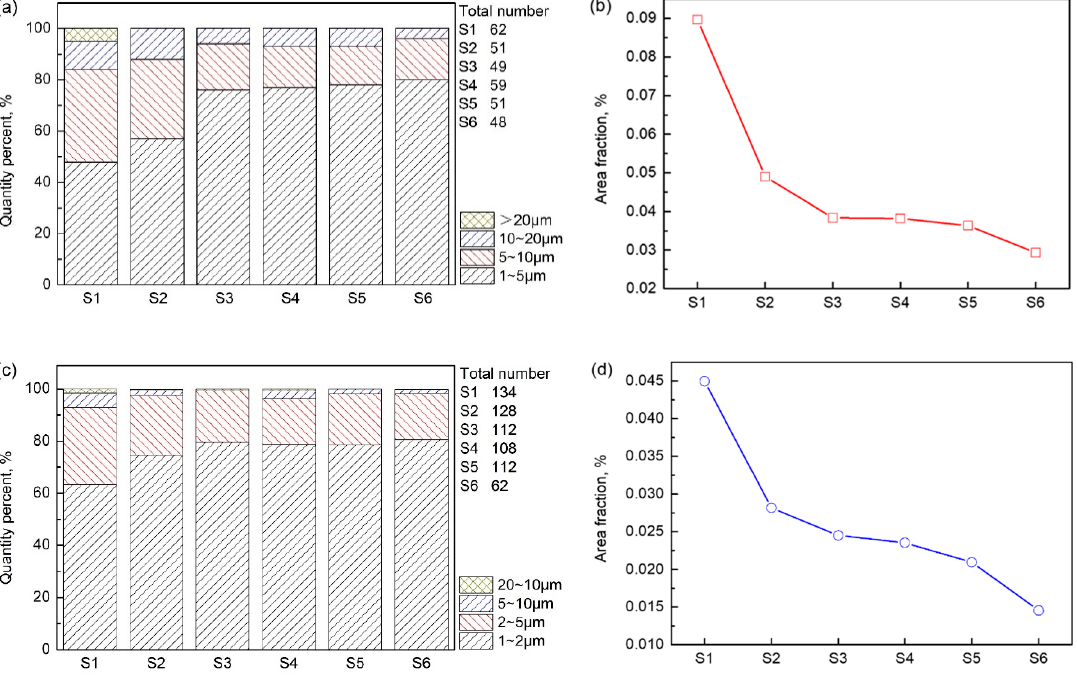
Figure 6. Statistical results of the primary carbides of each sample: ( a , b ) distribution of size and area fraction of V ‐ rich primary carbide; ( c , d ) distribution of size and area fraction of Mo ‐ rich primary carbide.